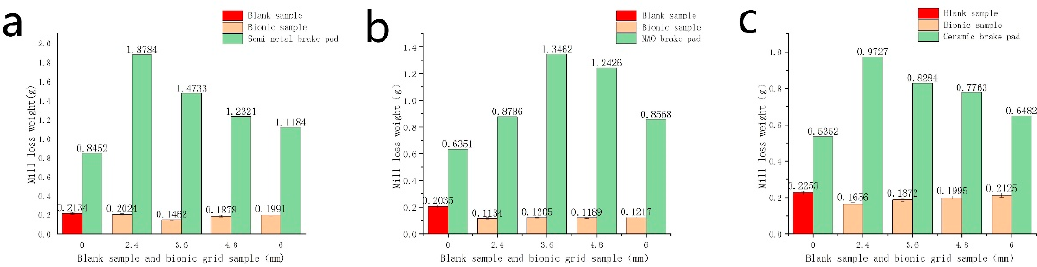
Figure 13. Wear test results of grid specimen and different brake pads. ( a ) The wear of grid bionic samples and semi-metallic brake ads; ( b ) the wear of grid bionic samples and organic asbestos-free (NAO) brake pads; ( c ) the wear of grid bionic samples and ceramic brake pads.